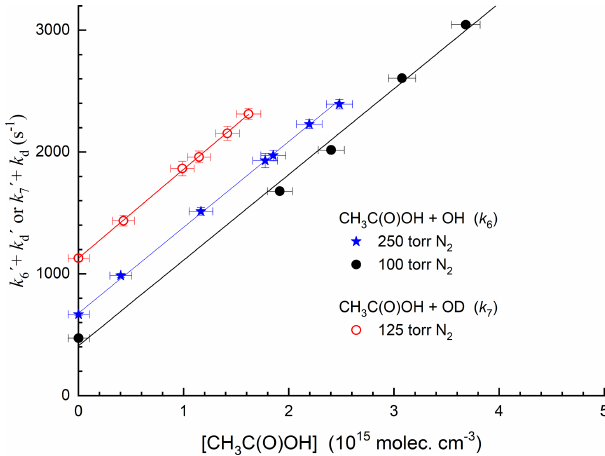
Figure 4. Plots of k (cid:48) versus [CH 3 C(O)OH] from the decays of OH and OD at different pressures of N 2 and 295K. The lines are least- squares fits to the data using Eq. (2). Error bars represent 2 σ statis- tical uncertainty. The different intercepts are due to use of different concentrations of H 2 O 2 (OH source) or DONO 2 (OD